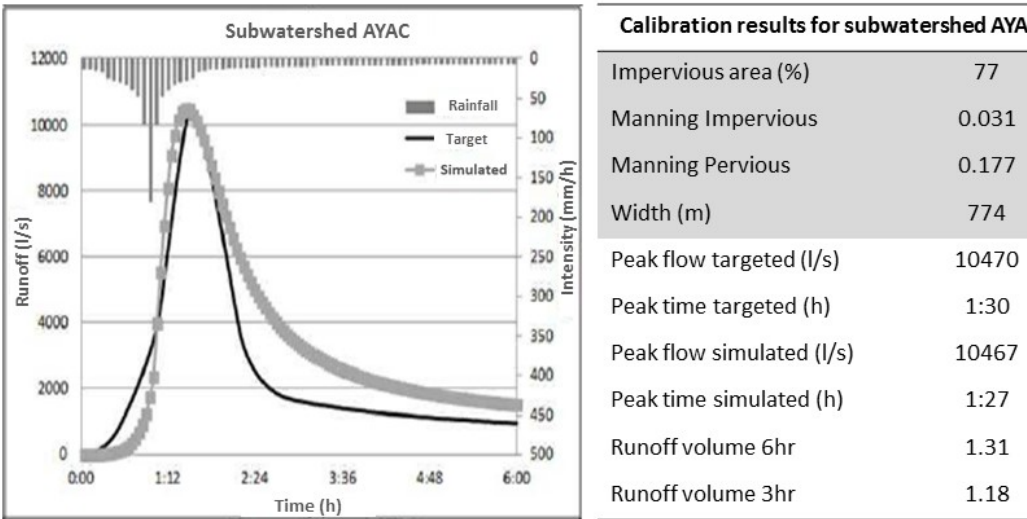
Figure 6. Hydrologic model calibration results for subwatershed AYAC (Runoff volume: target/simulated).